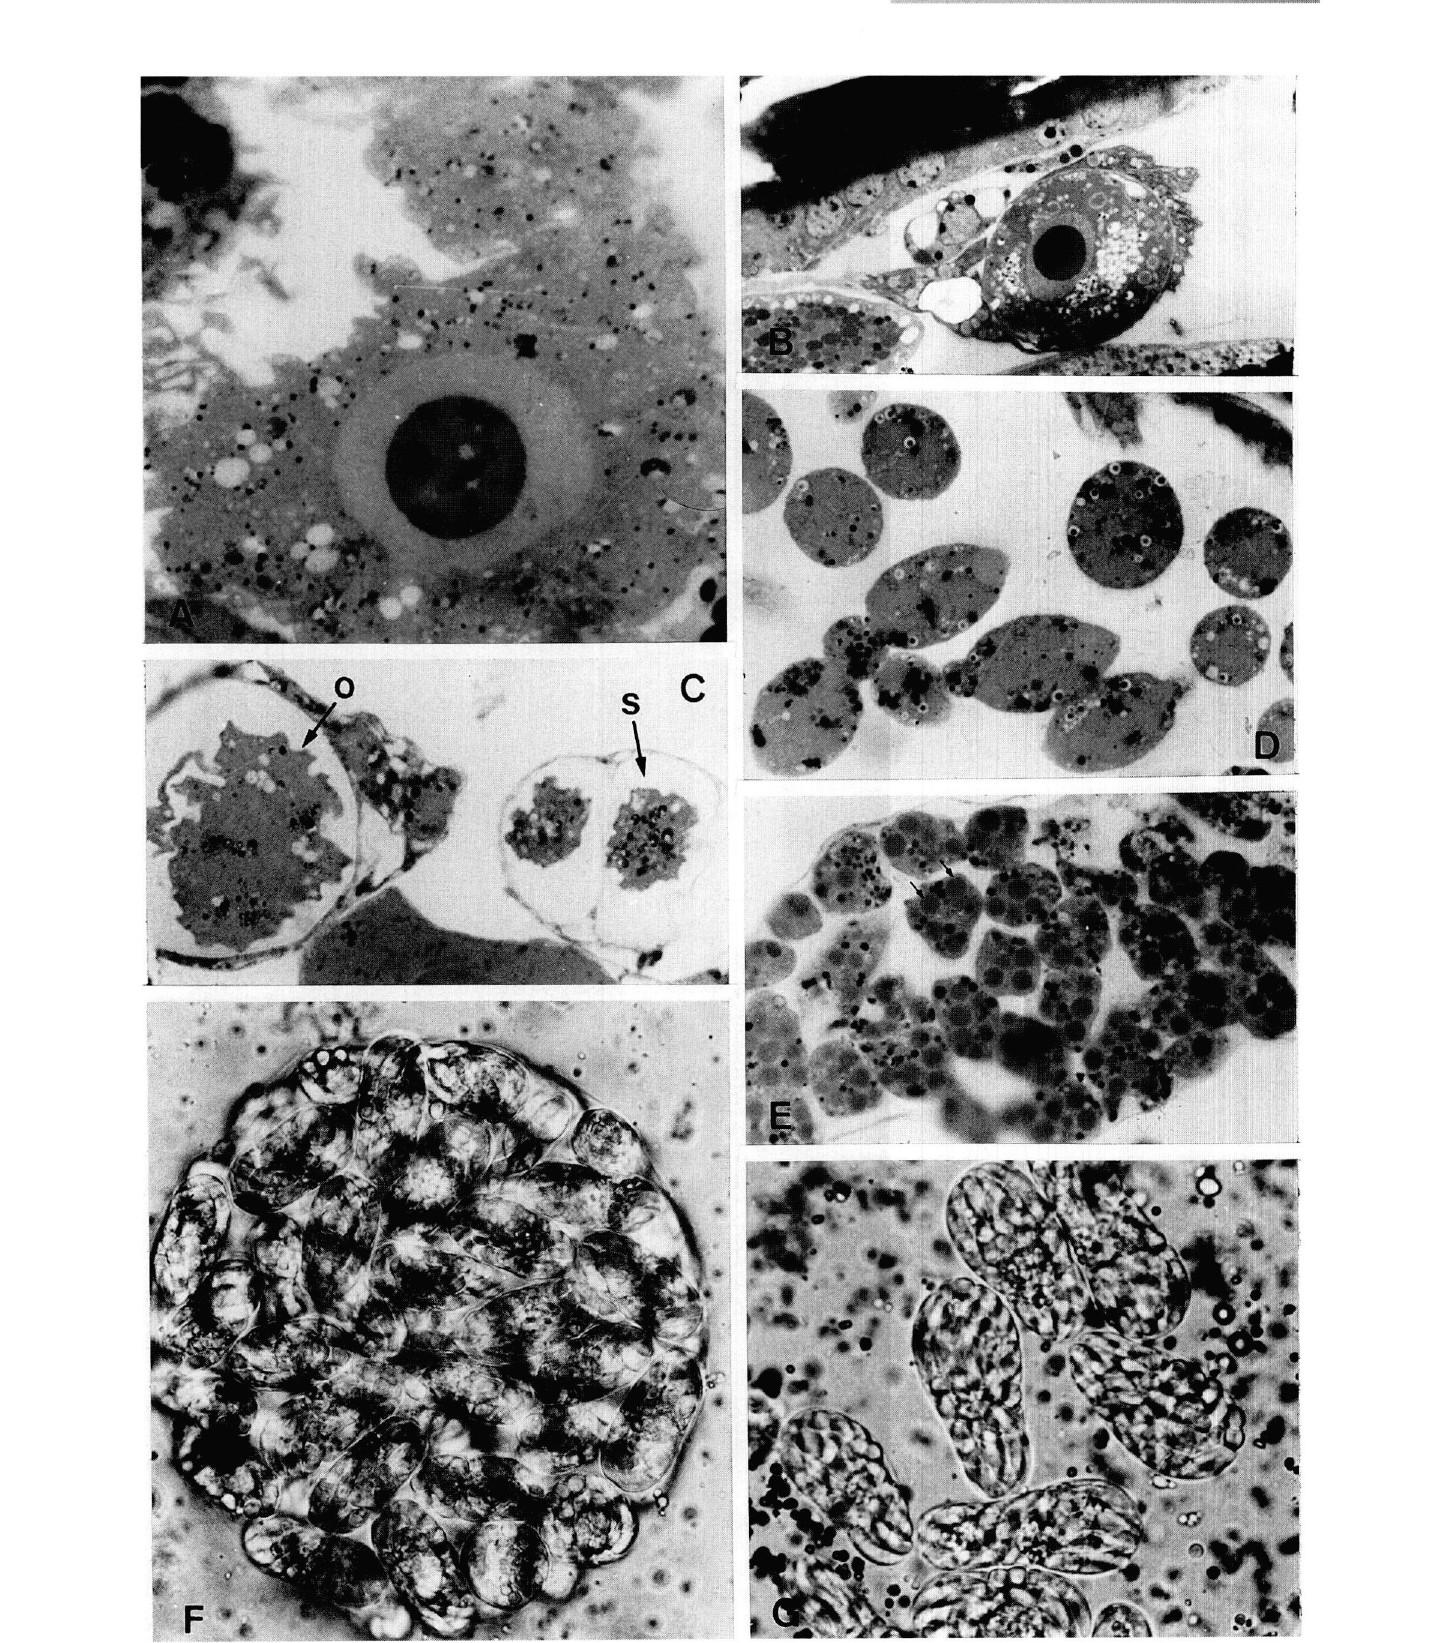
Fig. 3. - Developmental stages of Hepatozoon kisrae n. sp. in the tick Hyalomma cf. aegyptium. A-E, toluidine-stained semithin sections; F,G, unfixed, live: A,B. Oocysts, x 1,156 and x 462; C. Oocyst (o) dividing into sporocysts (s) x 500; D. Sporocysts x 887; E. Sporocysts with divided crystalline bodies x 939; F. Oocyst ball filled with ripe sporocysts x 324; G. Single sporocysts filled with sporozoites x 1,968.